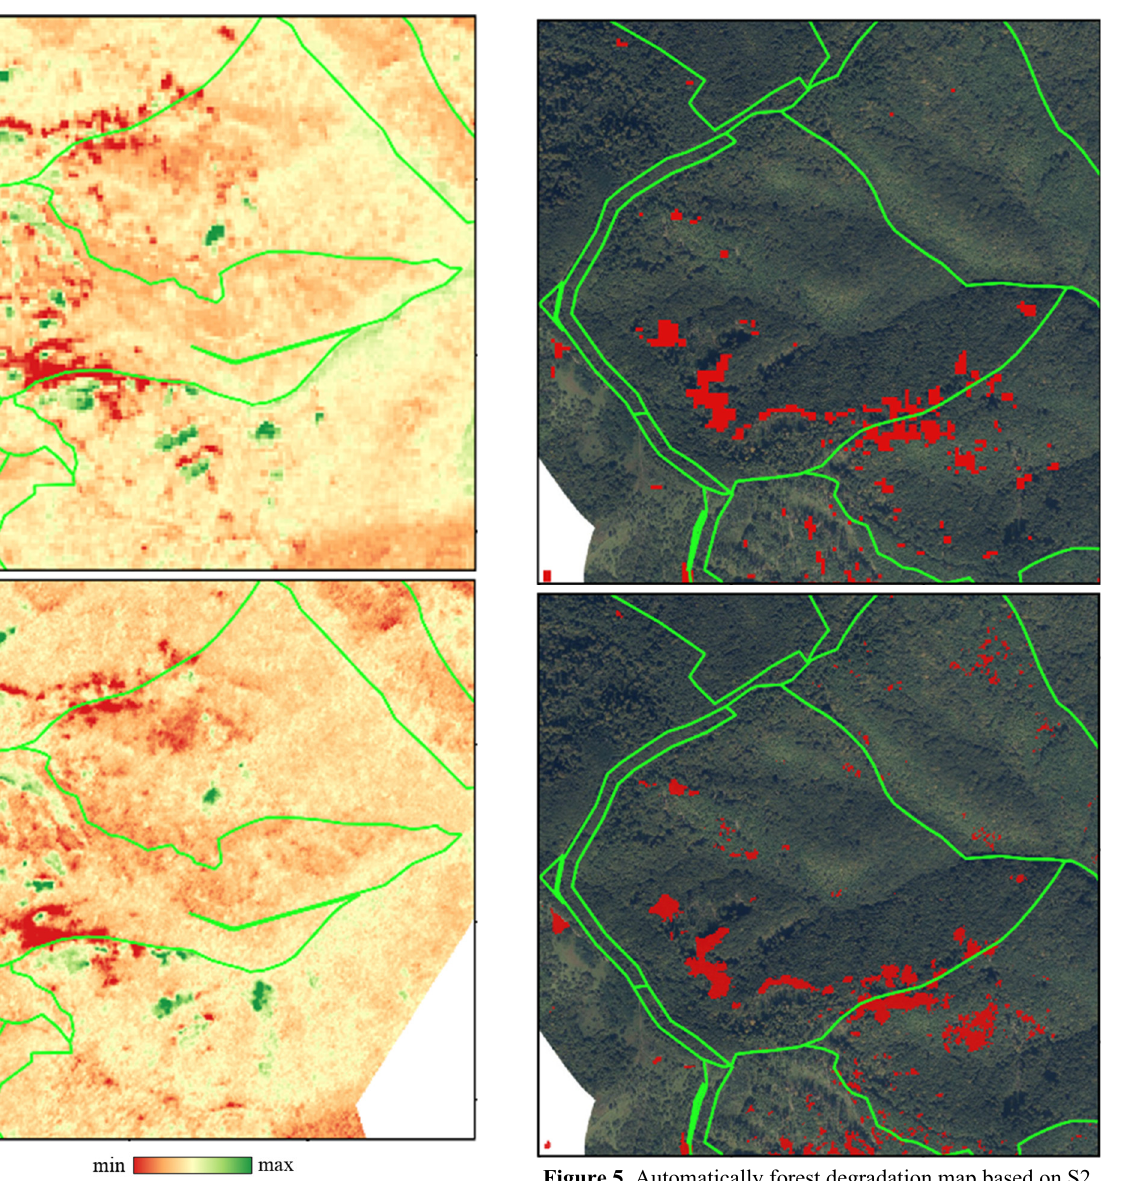
Figure 4. Automatically calculated ΔNDVI based composite for cloud- and shadow-free 10-m S2 mosaic for 2016 and 2021 years (above) and corresponding PlanetScope ΔNDVI (below) in 3-m spatial resolution for forest compartment/subcompartment 19B.